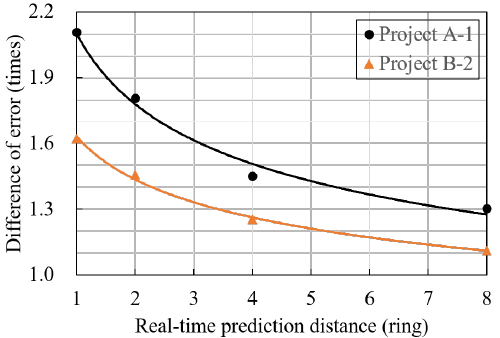
Figure 7. Difference in error (mean absolute percentage error (MAPE)) of ordinary least squares (OLS) with reference to ARIMAX in projects A-1 and B-2.